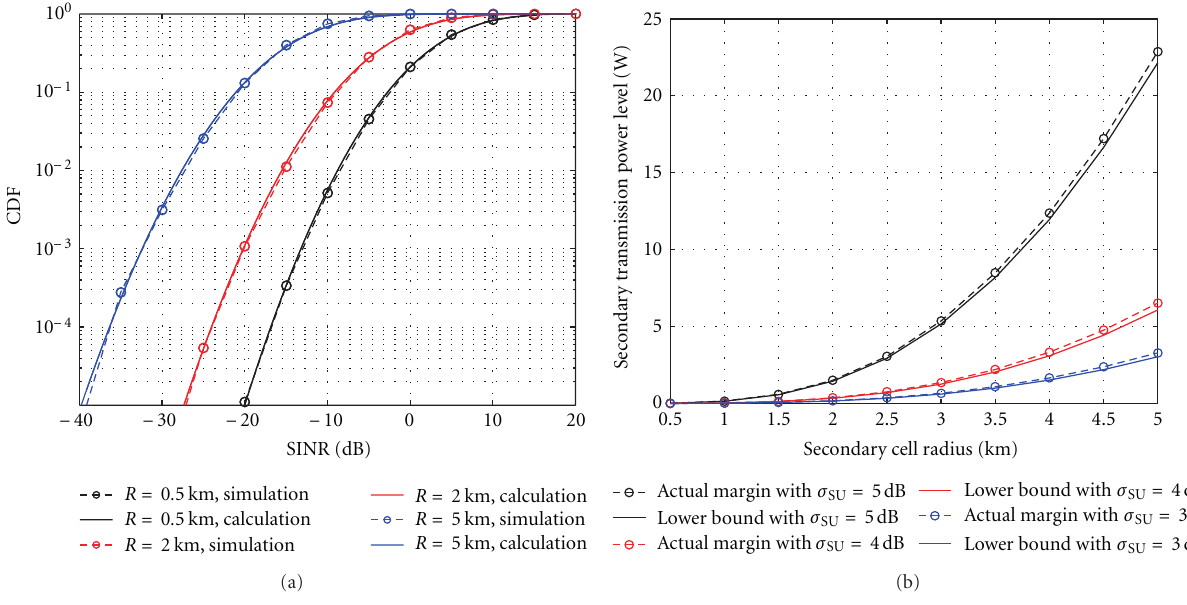
Figure 2: (a) Distribution of the SINR at the cellular cell borders. The simulations are compared to the calculations. In our calculations the aggregate interference is modelled by the log-normal distribution. Di ff erent secondary cell radiuses are tested. The standard deviation is taken equal to σ SU = 5 dB. (b) Transmission power level required to achieve SINR target γ t = − 3 . 5dB at the cellular cell border with outage probability O SU = 10% for di ff erent cell radiuses and reuse distance K = 3. The results obtained by using the actual interference margin (10) are compared to the results obtained by using the lower bound of the interference margin (11). The rest of the parameter setting can be found in Section 4.1.